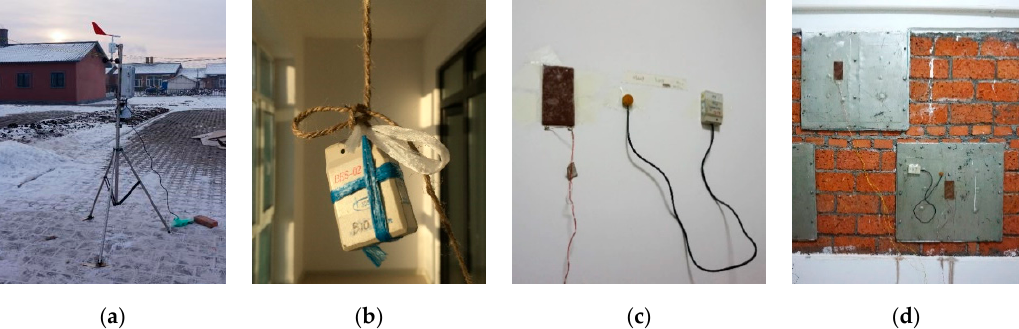
Figure 17. Test equipment layout. ( a ) Outdoor weather station on ‐ site; ( b ) indoor thermometer in the main room; ( c ) heat flow meter on the interior wall; ( d ) thermometer and heat flow meter on the phase change heat storage device in the firewall. Table 4. Test equipment.